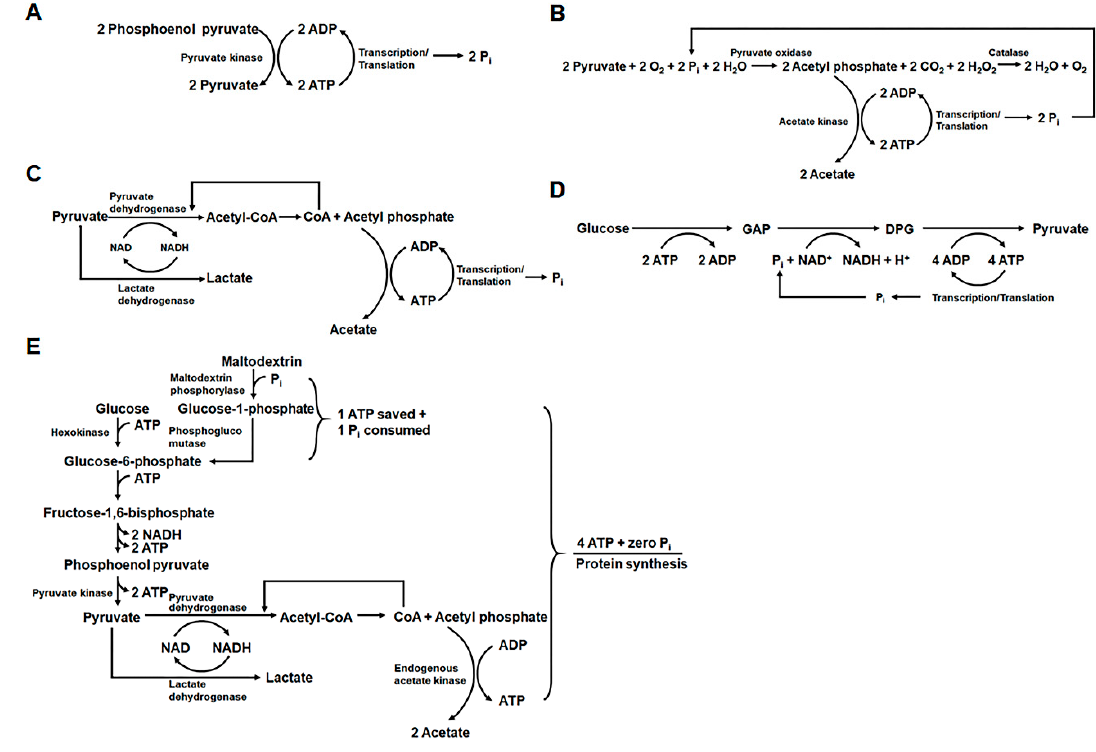
Figure 2. Biochemical strategies for enhanced supply of ATP without the accumulation of inorganic phosphate. ( A ) Conventional methods for ATP regeneration during cell-free protein synthesis simply rely on the substrate-level phosphorylation of ADP using the energy sources with high-energy phosphate bonds (i.e., phosphoenolpyruvate, creatine phosphate, and acetyl phosphate). In this scheme, inorganic phosphate accumulates in the reaction mixture in amounts proportional to those of the energy sources. ( B ) Kim and Swartz demonstrated that pyruvate can be used as a phosphate-free energy source, in combination with exogenously added pyruvate oxidase [16]. In their scheme, pyruvate and recycled inorganic phosphate produce acetyl phosphate, which is subsequently used to regenerate ATP. ( C ) Generation of acetyl phosphate from pyruvate can also be achieved by using the endogenous enzymes in the cell extract. ( D ) Use of glucose to regenerate ATP via glycolytic pathway in the cell extract. ( E ) Use of maltodextrin as a secondary energy source. ADP: adenosine diphosphate; ATP: adenosine triphosphate; Pi: inorganic phosphate; NAD: nicotinamide adenine dinucleotide; NADH: reduced nicotinamide adenine dinucleotide; GAP: glyceraldehyde-3-phosphate; DPG: 1,3- diphosphoglycerate.